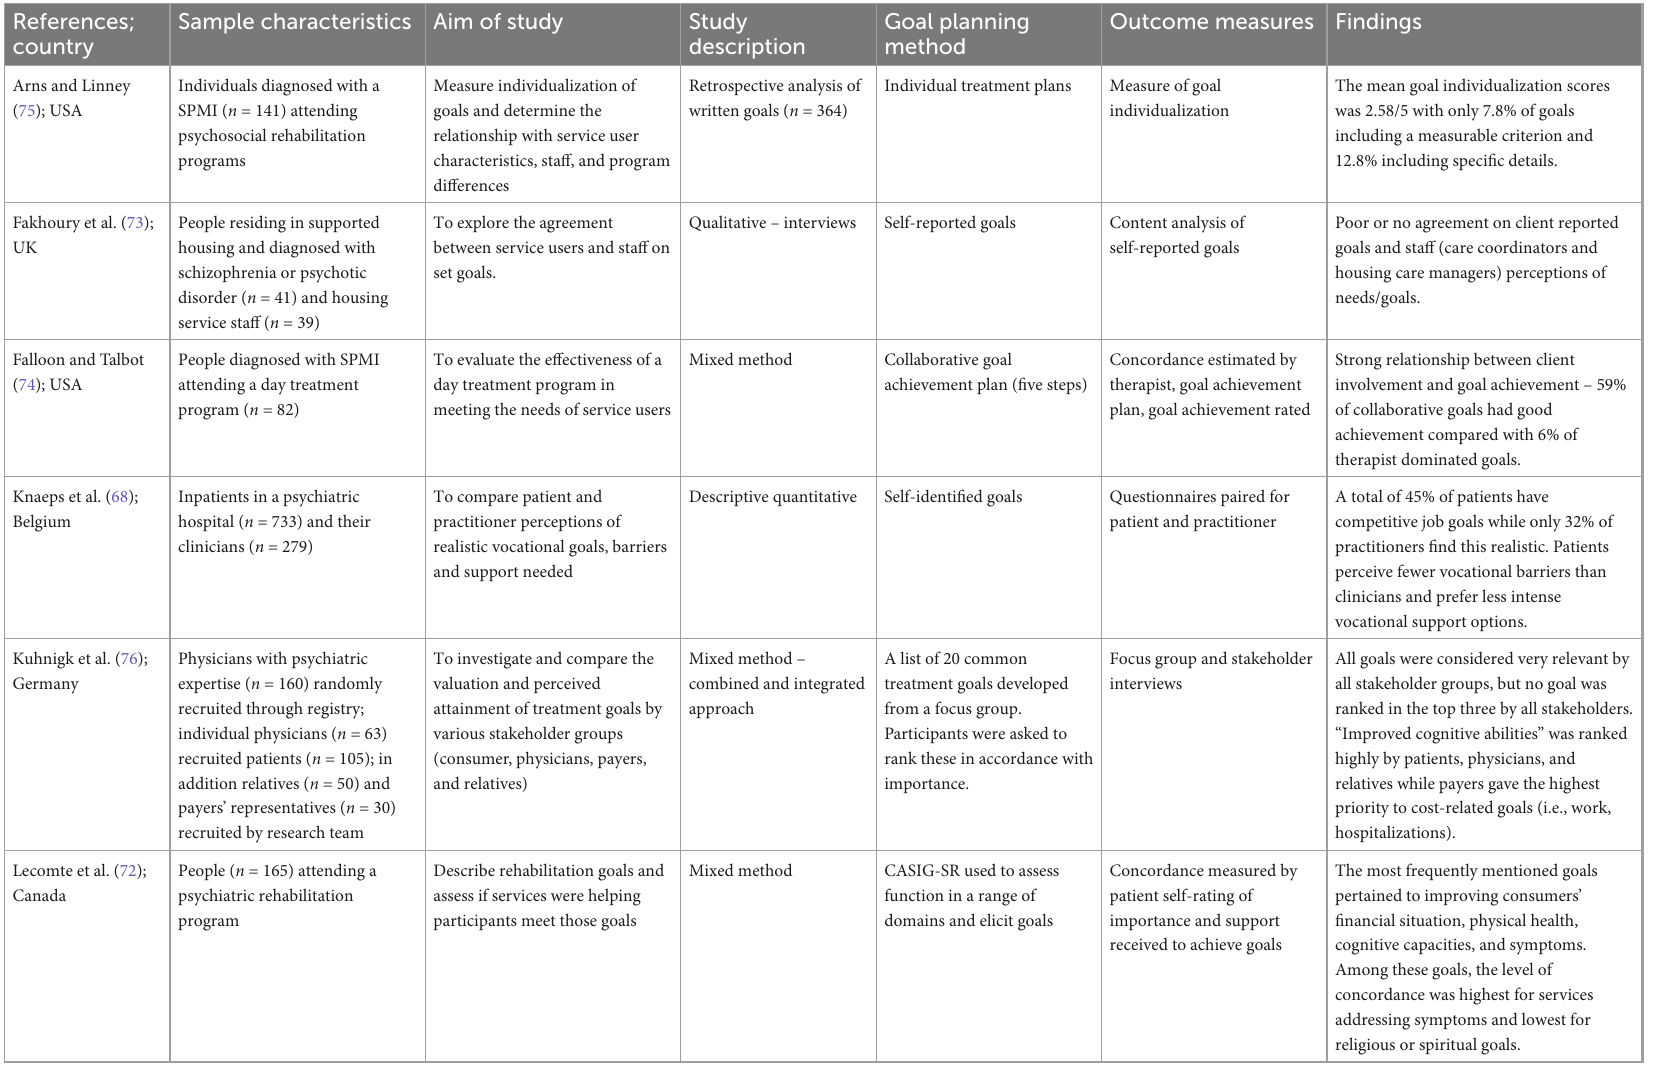
TABLE 4 Collaboration and concordance in goal